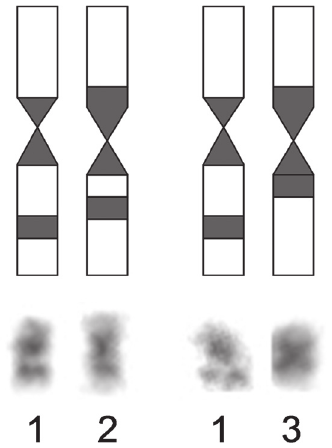
Figure 4. Scheme of localization of heterochromatic blocks on 8-th pair of Ochotona huangensis : 1 – the first homologue, 2 and 3 – the second homologue in two